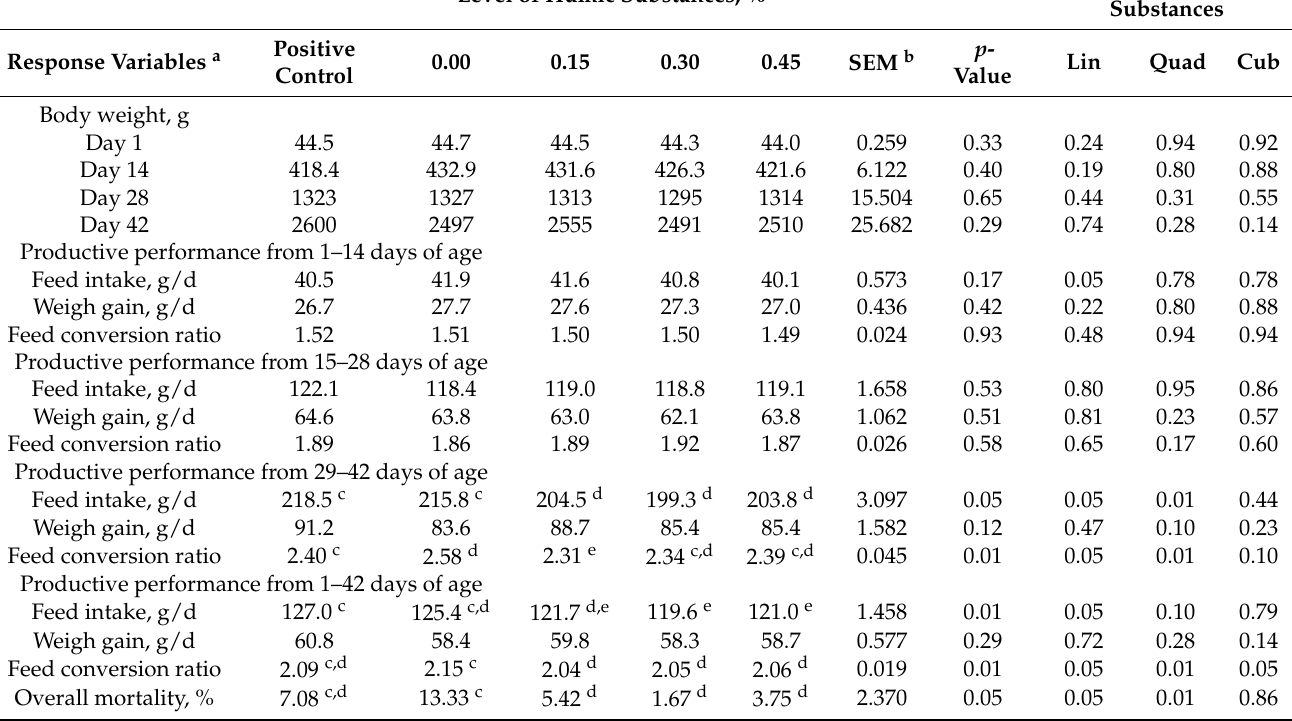
Table 2. Productive performance of broilers added with increasing levels of humic substances in the feed, probability level, and type of effect associated with humic